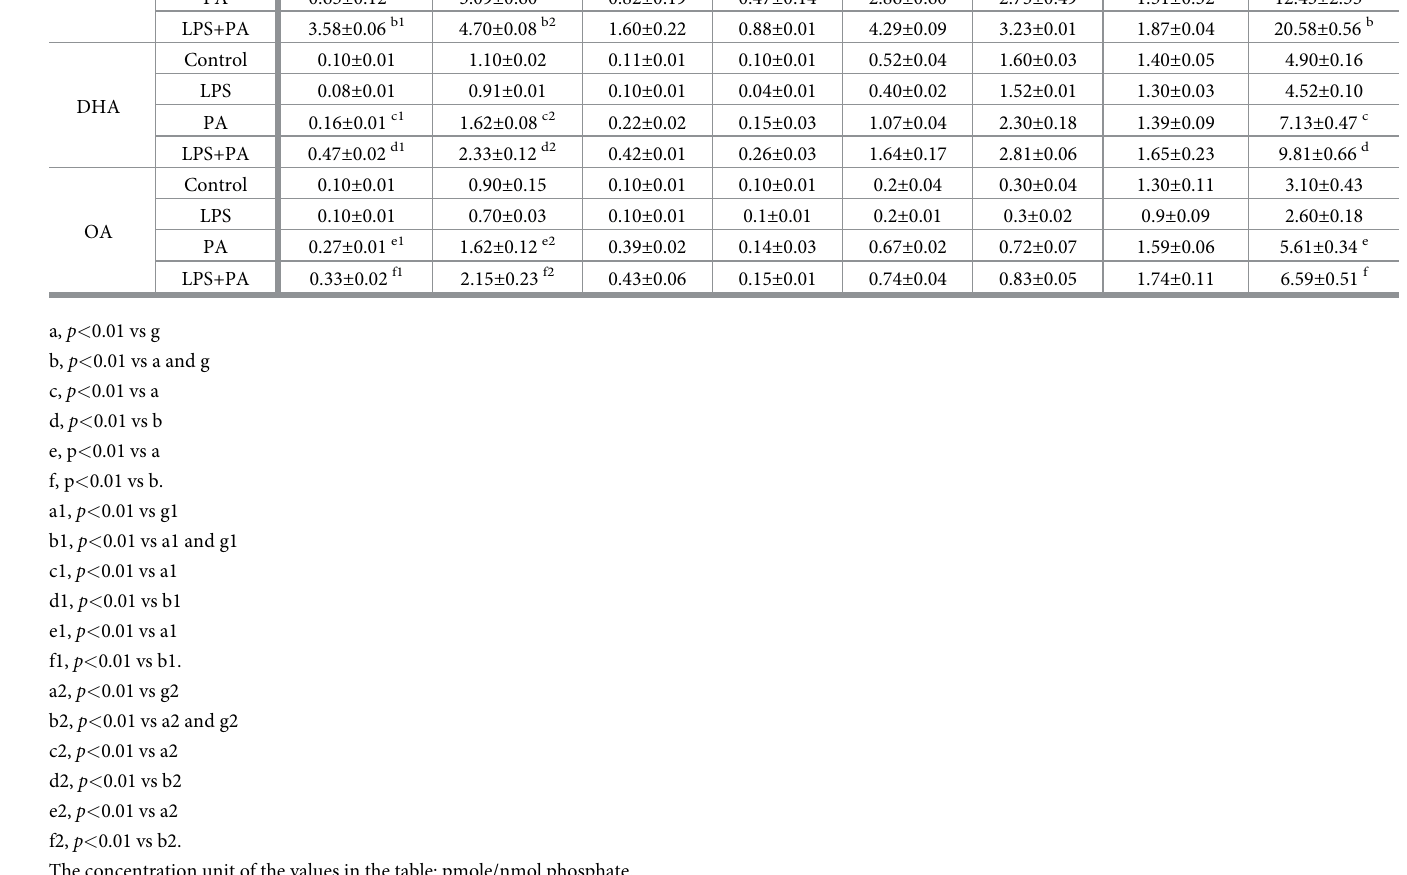
The concentration unit of the values in the table: pmole/nmol